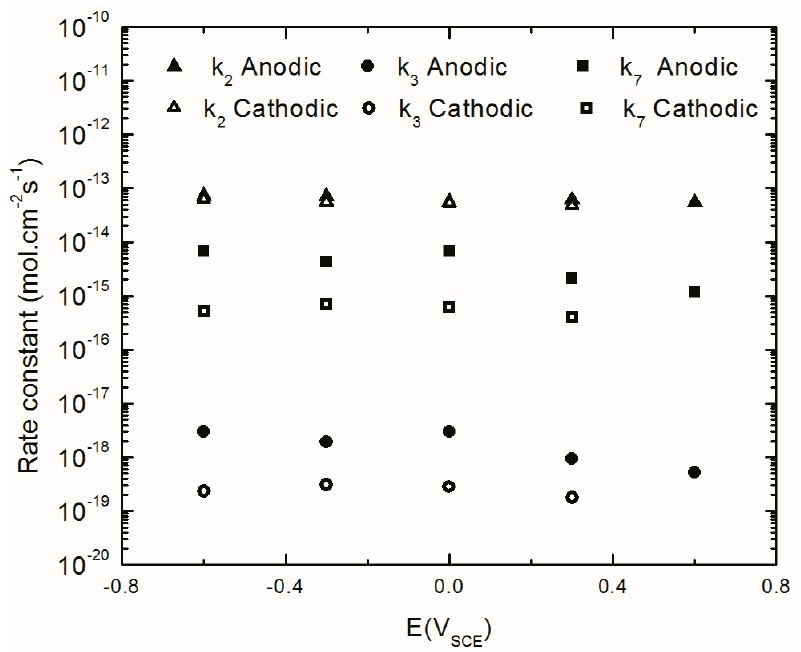
Figure 13. Rate constants for point defect reactions in Figure 7 obtained by MPM optimization of the EIS results at different stepping direction.